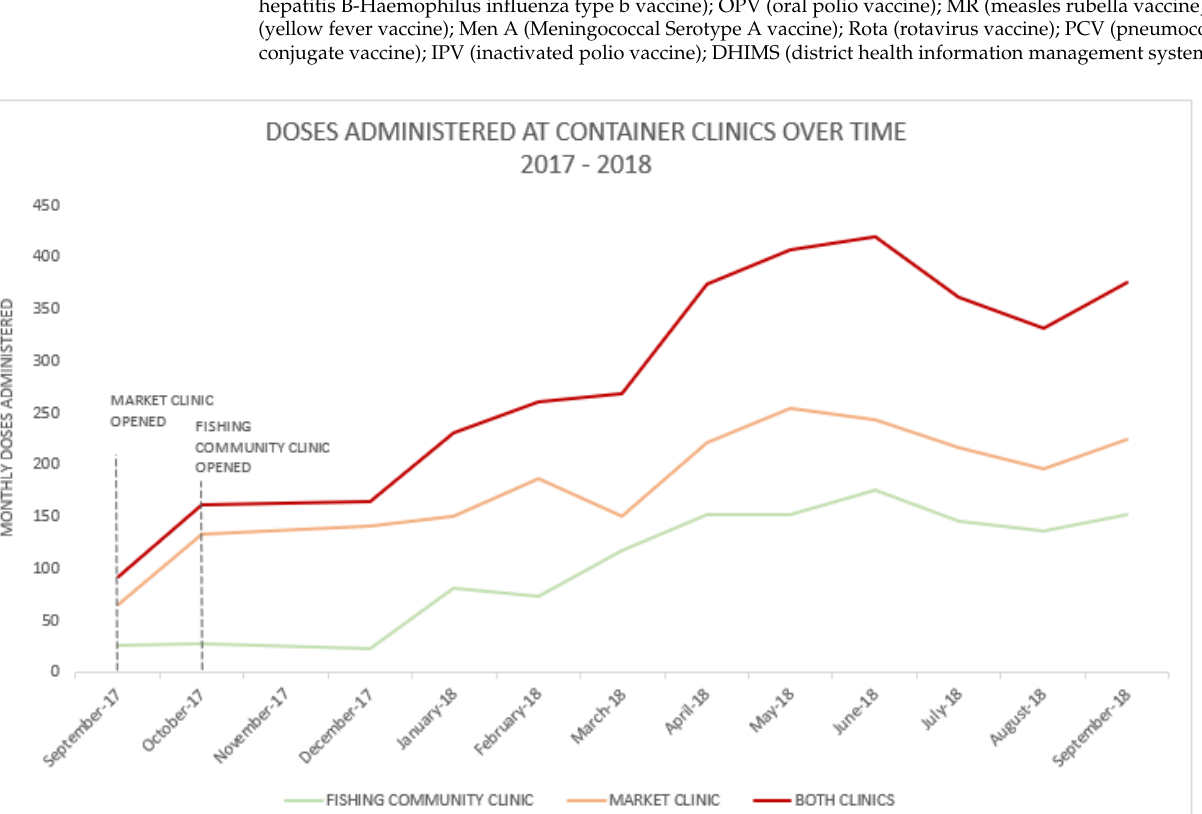
Figure 2. Panel line graph displaying total vaccine doses administered in two container clinics providing immunization services in Accra, Ghana, September 2017–September 2018. Total doses include Penta1-3, PCV1-3, Polio1-3, Rota1-2, MR1, YF, MR2, MenA, and IPV (introduced in June 2018). Abbreviations: “Penta” or Pentavalent vaccine (diphtheria-tetanus-pertussis-hepatitis B-Haemophilus influenza type b vaccine); OPV (oral poliovirus vaccine); MR (measles rubella vaccine), YF (yellow fever vaccine); Men A (Meningococcal Serotype A vaccine); Rota (rotavirus vaccine); PCV (pneumococcal conjugate vaccine); IPV (inactivated poliovirus vaccine). When assessing measles-rubella dose 1 (MR1) and MR2 specifically, both container clinics exceeded their annual target population for MR1 and MR2. For example, at the market clinic, the target population for 12–23 months was 150 children, and 180 doses of MR2 were administered. At the fishing community clinic, the target population for 12–24 months was 110 children, and 153 doses of MR2 were administered (Figure 3). The nurses also described an increase in vaccine uptake among the target population and improved immunization service utilization for traditionally underserved populations: It has really increased because we are actually now getting more than what we used to get. Like now, what we get in a week is more than the number we used to get for a month. —Nurse, the fishing community clinic …let’s take the kayayei, they sleep here unless festive seasons before they go to their places but some people too those who are from northern region, their vaccination is very poor because sometimes a five year old hasn’t taken Penta 3, no vitamin A at 6…when you go for visit you can look out for them and give them the vaccines. —Nurse, the market clinic.